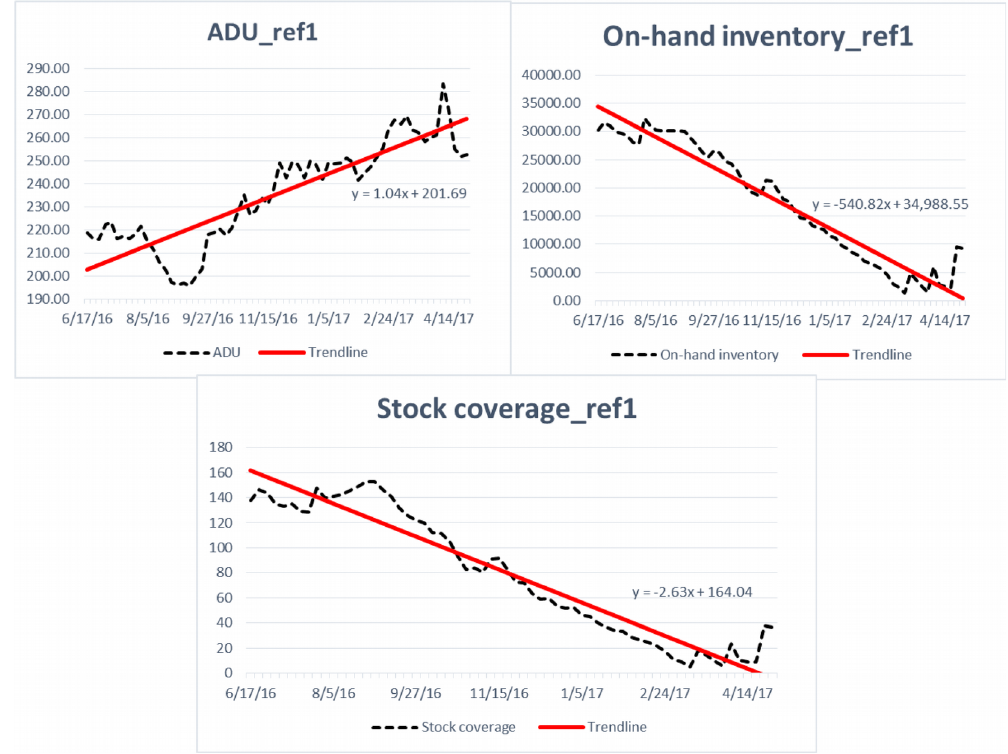
Figure 12. (a) the ADU, (b) on-hand inventory and (c) stock coverage of Ref1 of the analyzed family